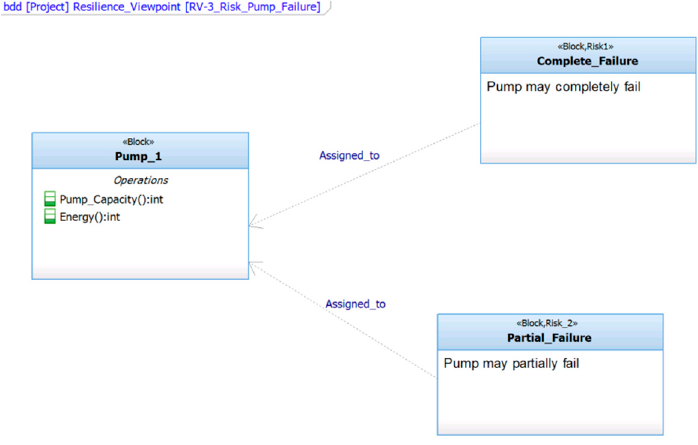
Figure 12 . Resilience View 3 (RV-3)—Risk view description. Figure 12. Resilience View 3 (RV-3)—Risk view